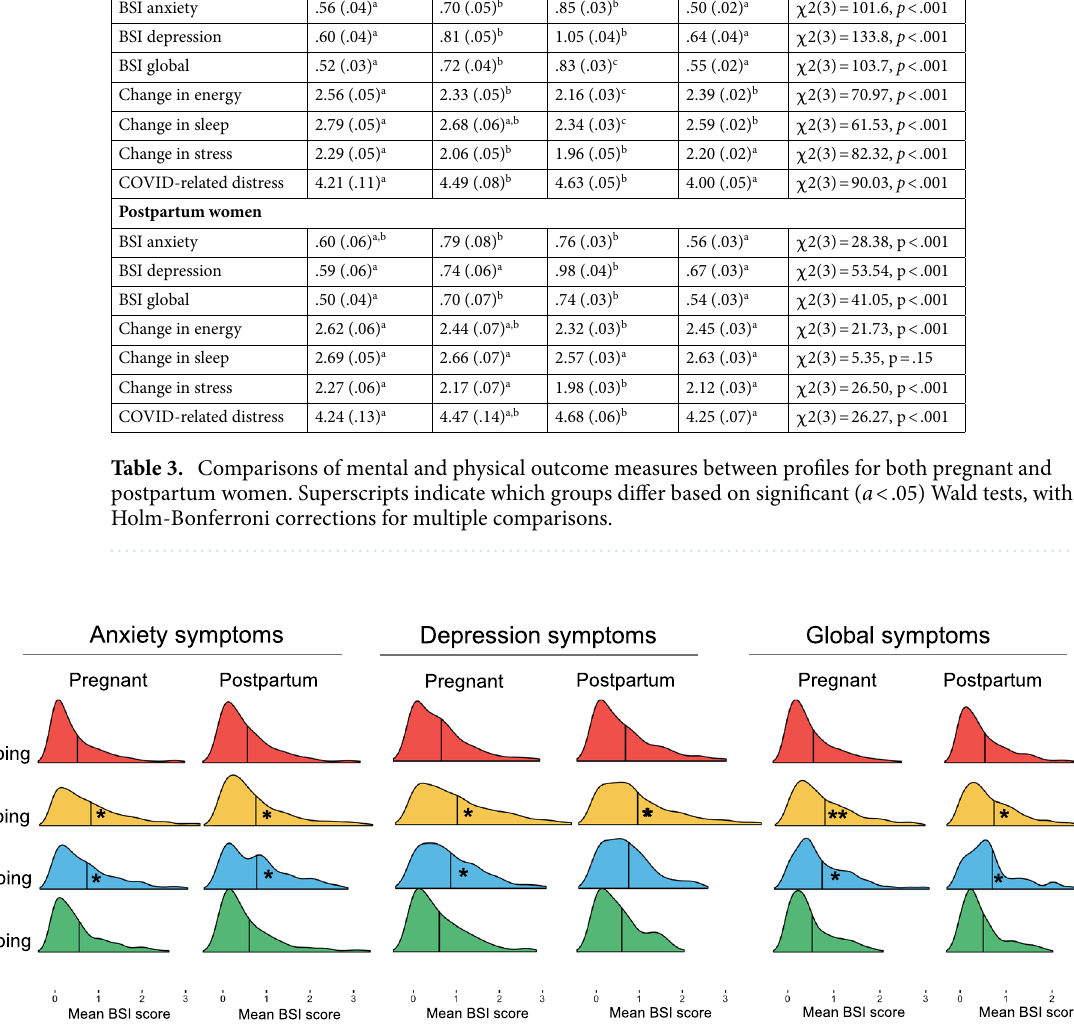
Figure 4. Distributions of anxiety, depression, and global BSI scores by profile for pregnant and postpartum women, based on most likely profile membership. Solid lines indicate estimated means. Asterisks indicate which profiles had significantly higher